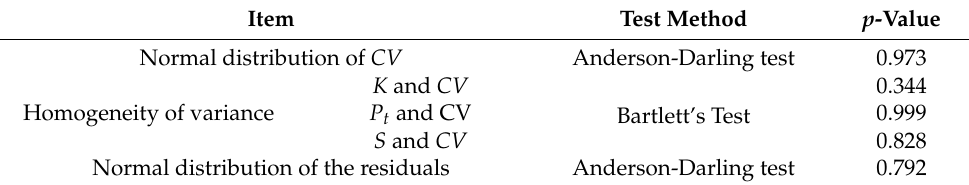
Table 5. Statistical assumptions for variance